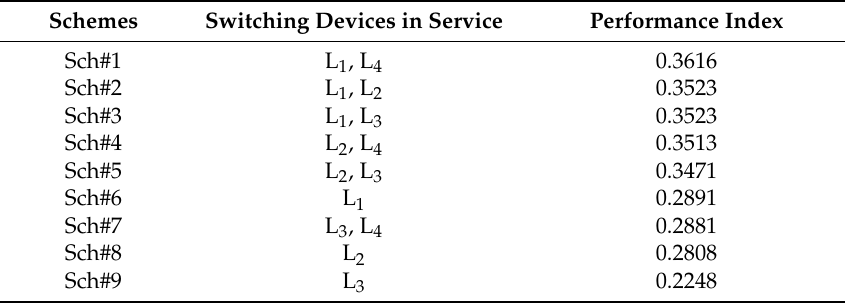
Table 3. The feasible set in Case 1.